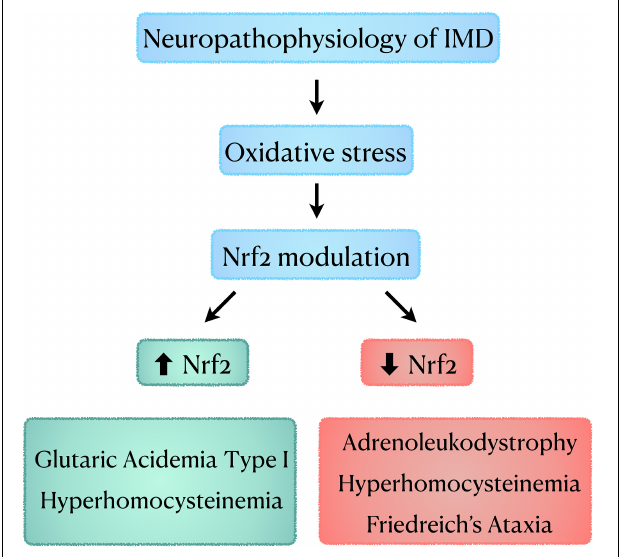
FIGURE 2 | Schematic diagram showing the role of oxidative stress and Nrf2 modulation in the neuropathophysiology of IMD. IMD, Inherited Metabolic Disorders; Nrf2, nuclear factor erythroid-2-related factor